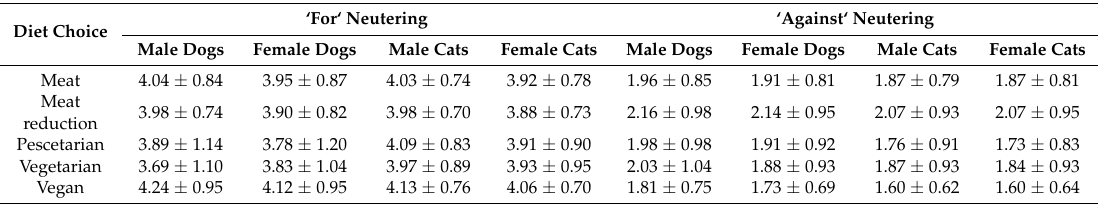
Table 4. Mean agreement scores ( ± SD) for participants by diet choice (meat (n = 176), meat reduction (n = 44), pescetarian (n = 18), vegetarian (n = 24) and vegan (n = 28)) supporting or opposing routine neutering of each animal